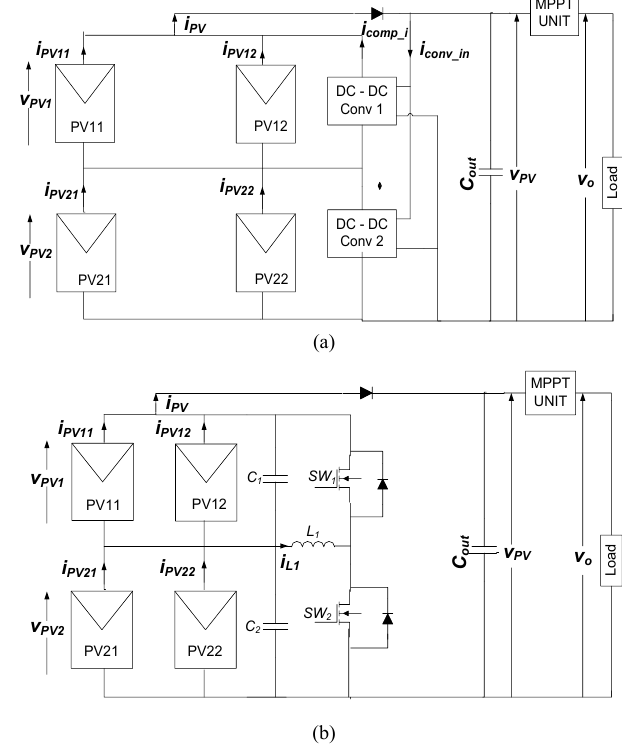
Fig.6 System configurations having two ties for evaluating the two approaches: (a) TCT-CC[15] ; (b)TCT- GCC.